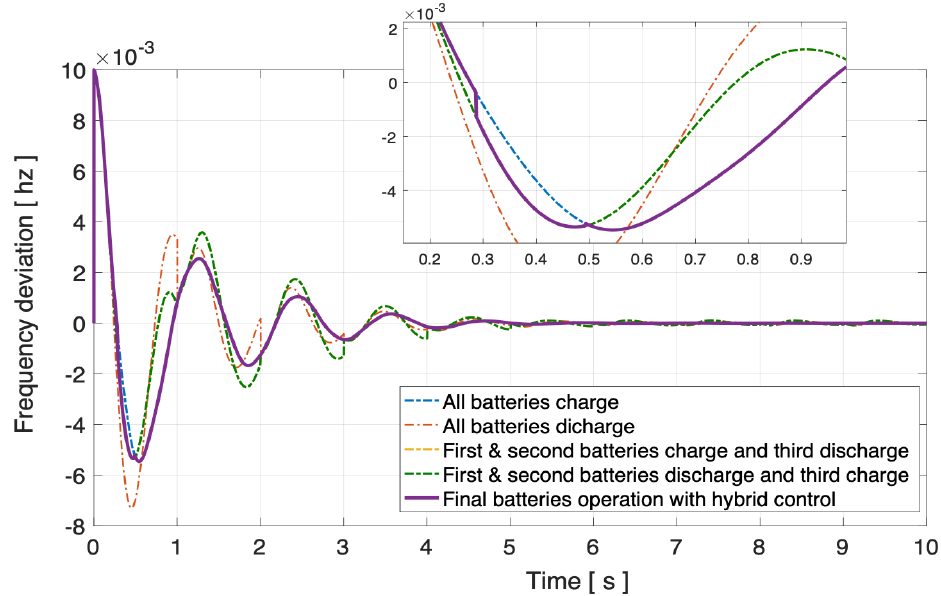
Figure 6. Frequency deviations of the generator number three in the second area for different scenarios and hybrid control final